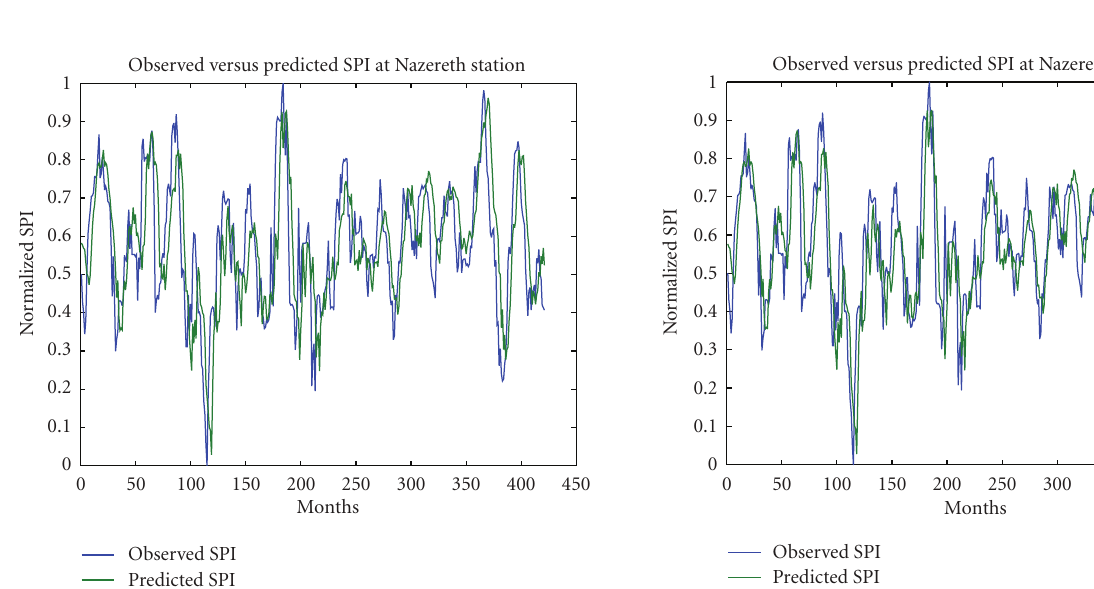
Figure 6: SPI 12 forecast results for the best WN model at the Nazereth station (1-month lead